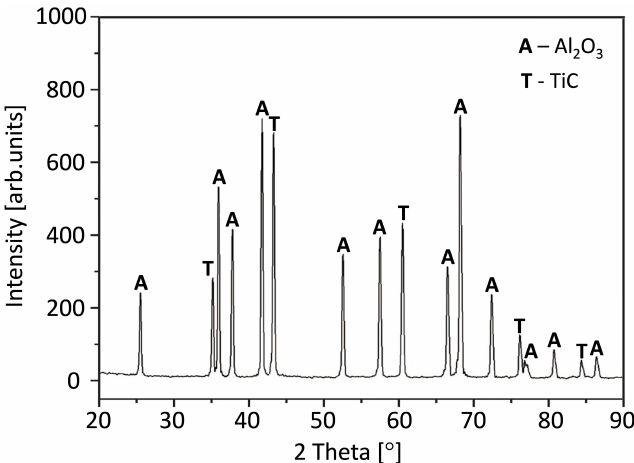
Figure 1. XRD pattern of the polished surface of Al 2 O 3 -TiC composites, where A is α -alumina, and T is TiC.